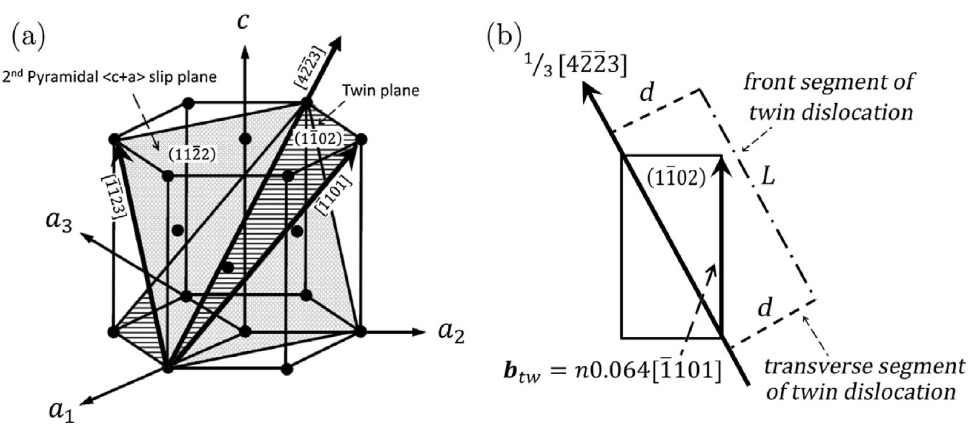
Figure 13. Crystallographic schematic showing the dissociation of pyramidal (cid:104) c + a (cid:105) dislocation in ( 1122 ) plane ( a ) into twinning dislocation on ( 1012 ) plane ( b ), reproduced from [109], with permission from Elsevier